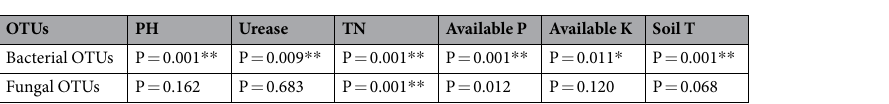
Table 3. Relationship between environmental and number of operational taxonomic units (OUTs) of continuous cropping ramie in different areas. Notes: * and ** indicate significant differences at p = 0.05 and p = 0.01, respectively.